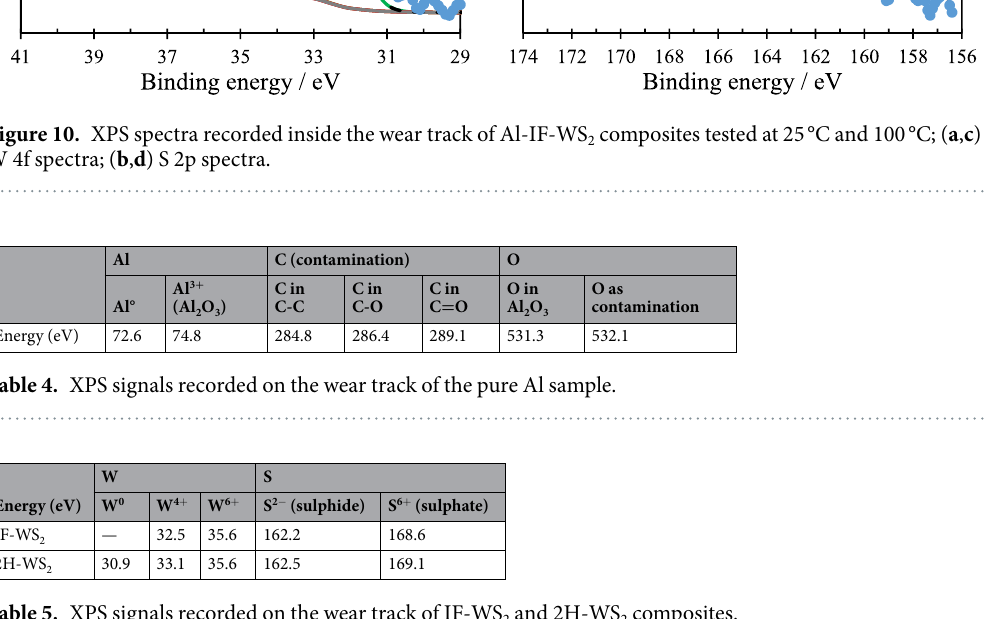
Table 5. XPS signals recorded on the wear track of IF-WS 2 and 2H-WS 2